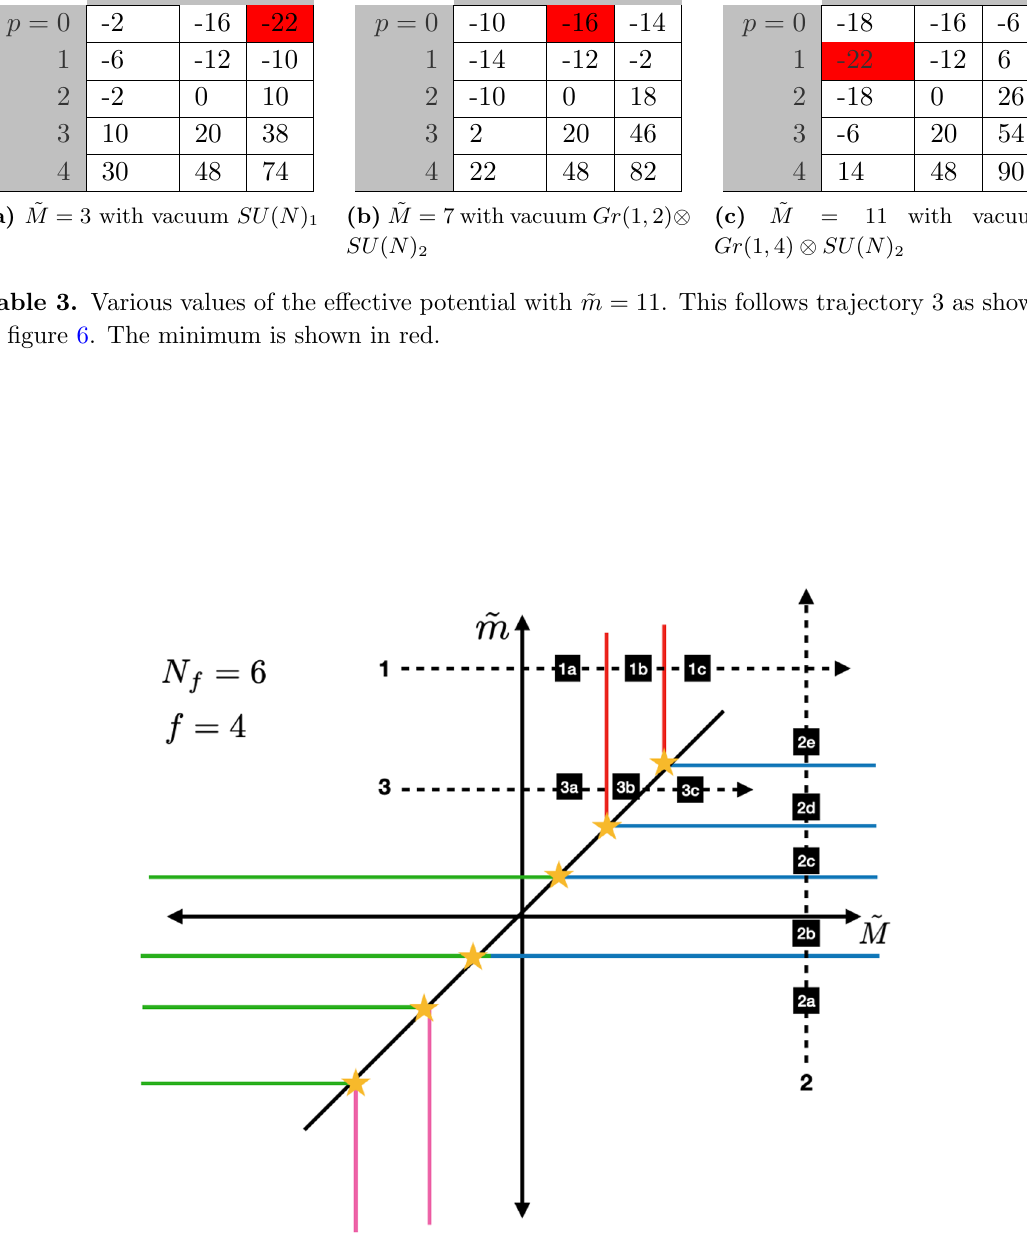
Figure 6. Phase diagram for N f = 6 ; f = 4 with k = 0. Various e(cid:11)ective potential at the indicated points along trajectories 1,2 and 3 shown are given in tables 1, 2 and 3.